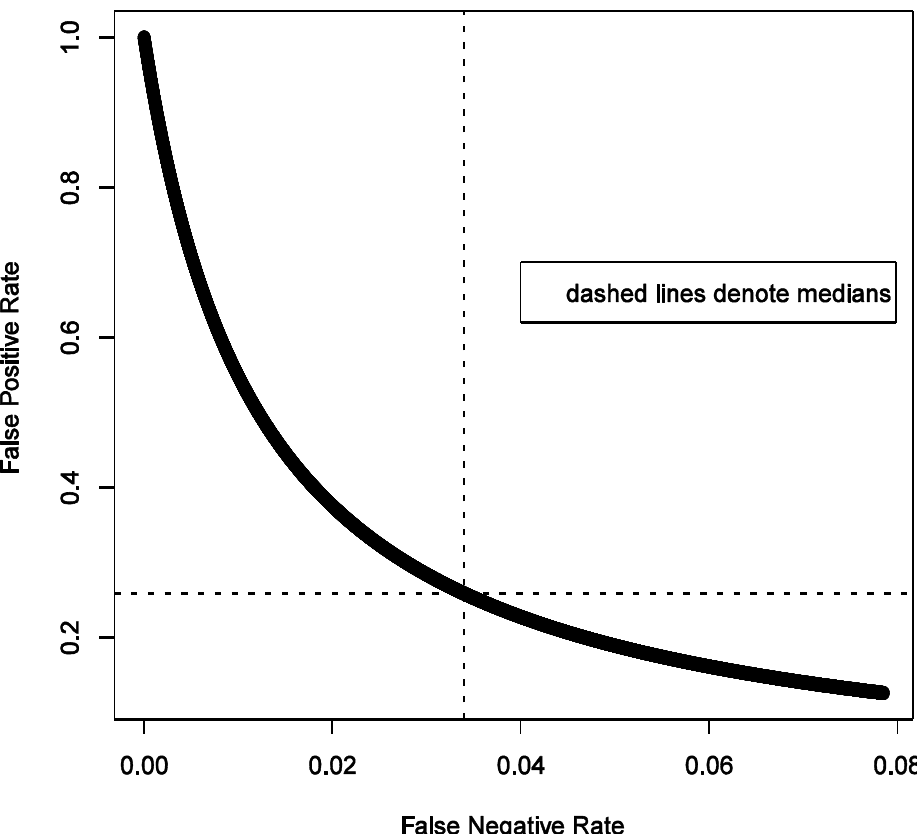
Figure 9. Illustrated relationship between false positive and false negative rates in a hypothesis generating study: 20,000 Monte-Carlo simulations when exposure is imperfectly classified (sensitivity 0.5 and specificity 0.9) for fixed distribution of belief about probability of the effect being null (1500 case-control sets, type I error 5%, prevalence of exposure 30%, true odds ratio